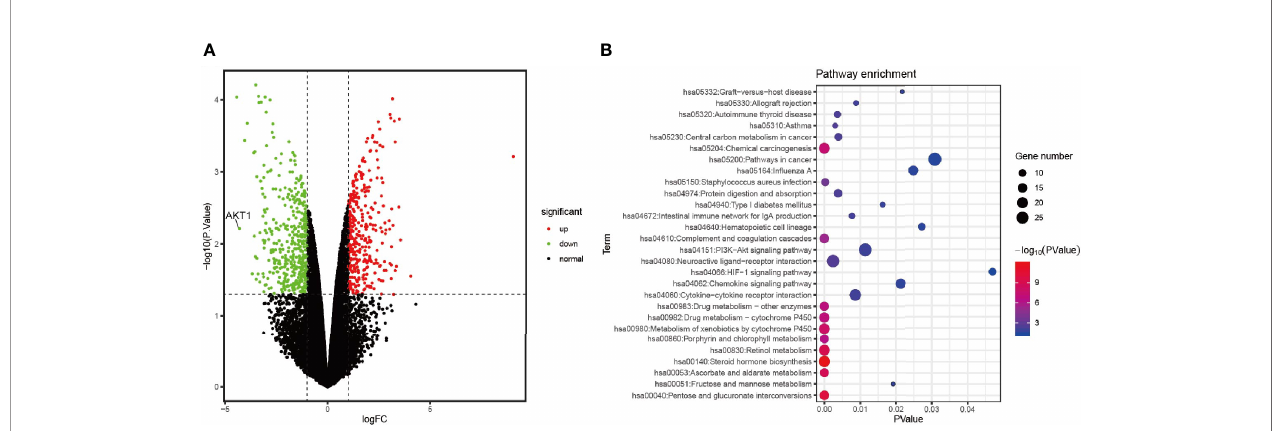
FIGURE 5 | Emodin arrests AKT1 expression and Chemical carcinogenesis signaling pathway in MCF-7 (A) The volcanic map of DEGs in GSE111803 data set. (B) Pathway enrichment of DEGs.